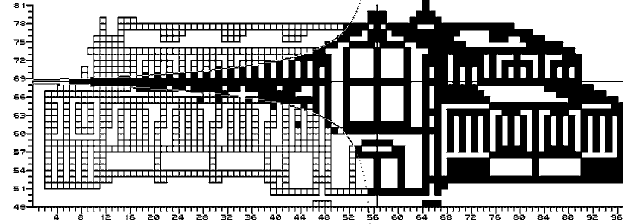
Figure 17: The MIDI pitch-time map of the score of the first part of Le loup en pierre.